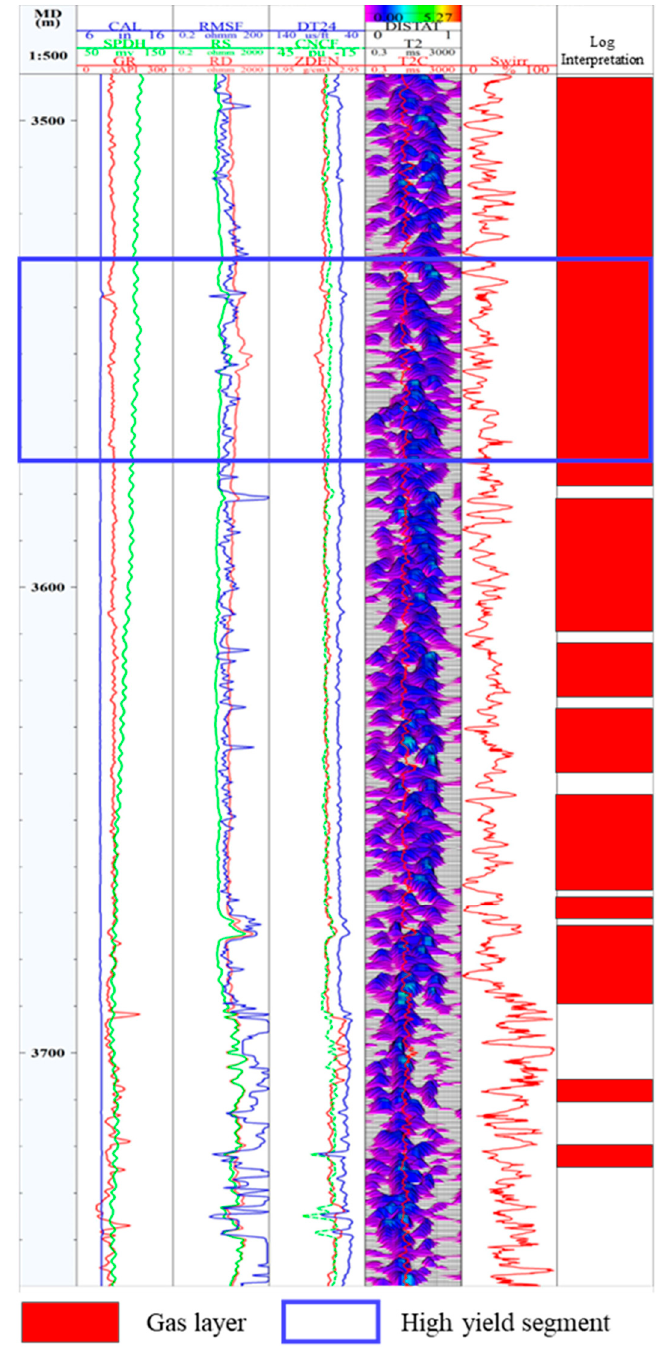
Figure 17. Logging diagram of Well-B5 in Bozhong Sag. In the fifth track, the T 2 spectral shapes at different depths are different, and the T 2 spectrum of the whole formation has no obvious change trend from top to bottom (Figure 17). In the interpreted well sections, there is a unimodal distribution, bimodal distribution and multimodal distribution for the T 2 spectral shapes. The red line in the fifth track is the calculated T 2C value based on the method discussed above. The